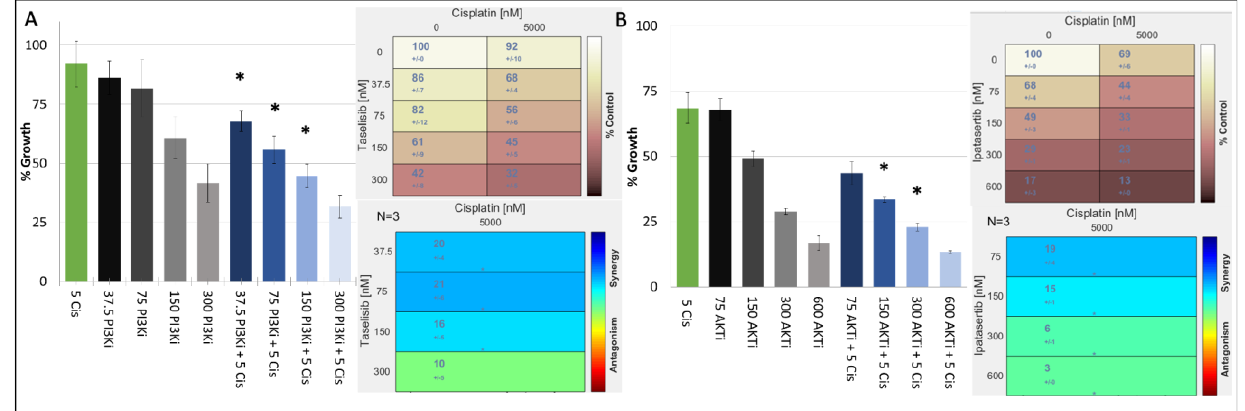
Figure 2. Growth inhibitory effect of cisplatin (μM) in combination with either A) taselisib (PI3K inhibitor) (nM) or B) ipatasertib (AKT inhibitor) (nM) in the MFM223 breast cancer cell line (TP53 Mutant/PIK3CA Mutant). Standard deviations are calculated from triplicate independent assays. Statistical analysis conducted using Prism, where a p -value of <0.05 was deemed statistically signif- icant using a repeated measures ANOVA, which was corrected using Tukey’s multiple comparison test. Significant results are indicated with ‘*’. ( A ) Combifit analysis calculates the average % growth of either cisplatin or taselisib tested alone or in combination, whilst Loewe analysis calculates the synergy of the combination. ( B ) Combifit analysis calculates the average % growth of either cisplatin or ipatasertib tested alone or in combination, whilst Loewe analysis calculates the synergy of the combination cisplatin and ipatasertib tested alone or in combination.